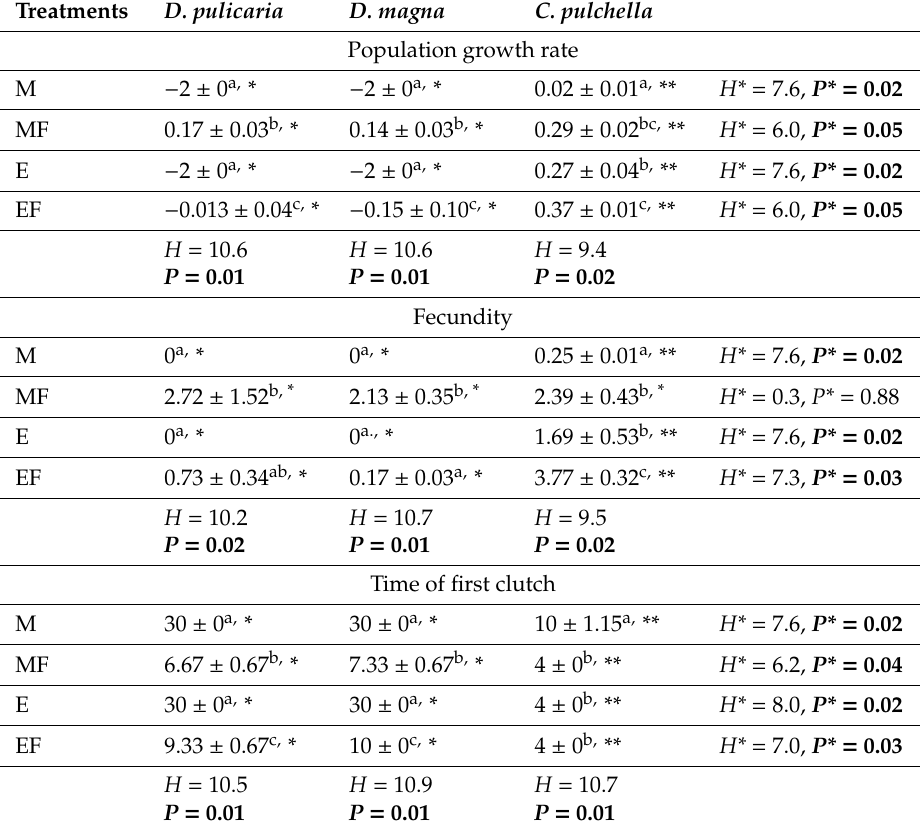
Table 11. Demographic parameters ( ± SE) of D. magna, D. pulicaria , and C. pulchella in E—eutrophic, M—mesotrophic, F—fish treatments; Kruskal–Wallis (H) test and Dunn’s post hoc test ( P < 0.05) were used for pairwise comparisons of population growth rate, fecundity, and time of first clutch along the columns and along the lines. P significant values are given in bold; means labeled with the same letter / asterics are not significantly di ff erent along the same columns / line. Letters are given for comparisons along the columns, while asterisks show discrepancies along the